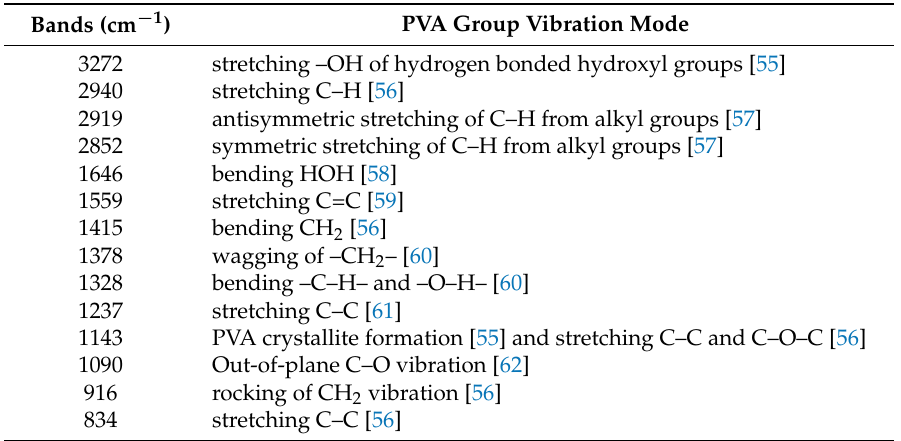
Table 3. PVA’s Fourier-transform infrared spectroscopy (FTIR) bands and vibration